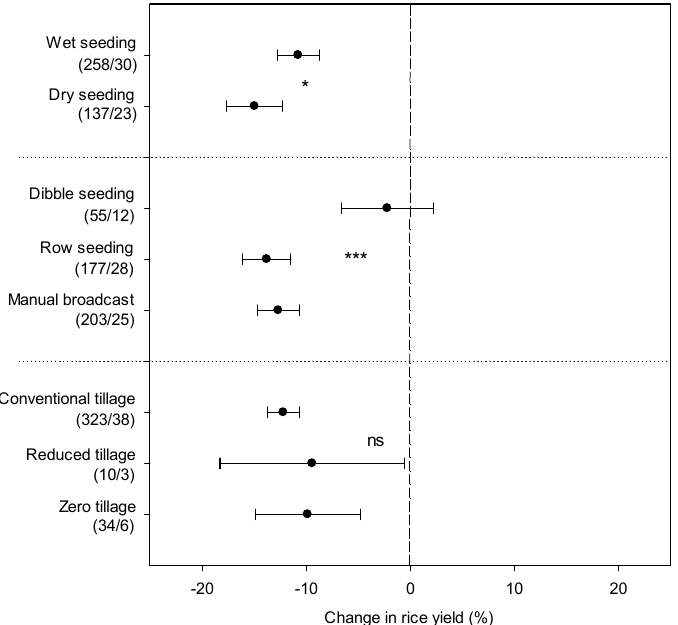
Figure 2. Influence of different crop establishment, seeding methods, and tillage practices on the yield change of direct-seeded rice relative to transplanted rice. The number of paired observations/number of studies included in each dataset are presented in parenthesis. Significant differences by categories are based on randomization tests; ns denotes non-significance at 0.05, * denotes significant at p ≤ 0.05, ** denotes significant at p ≤ 0.01, and *** denotes significant at p ≤ 0.001.